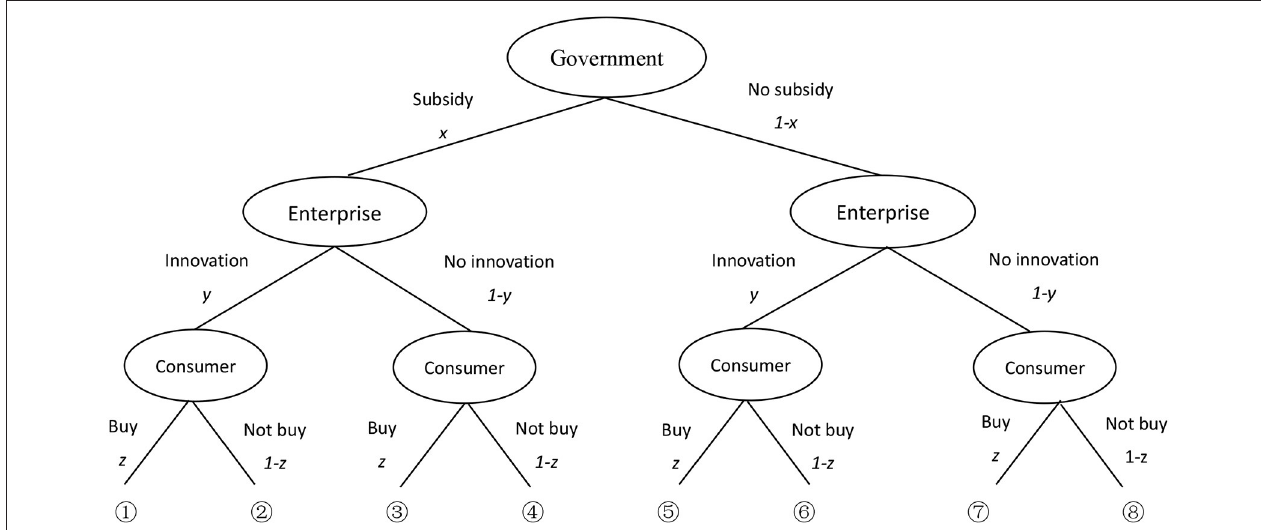
FIGURE 2 | Tripartite game model of government, enterprises and